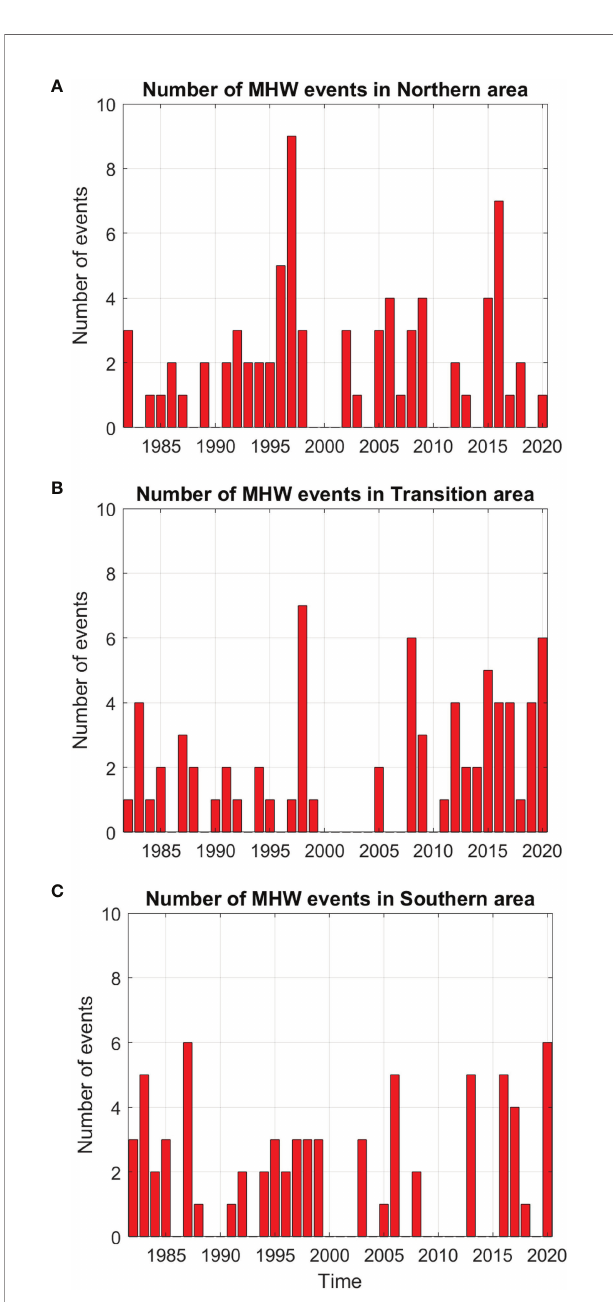
FIGURE 3 | Number of marine heatwave events (MHW) that have occurred each year from 1982 to 2020 for Northern (A) , Transition (B) and Southern (C)